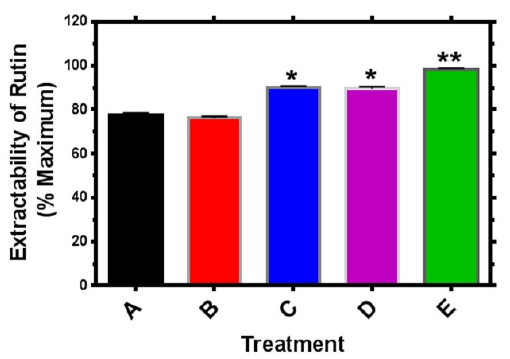
Figure 3. Extractability of rutin from the dried leaves of M. stenopetala . After the dried leaves were subjected to different extraction treatments, the amount of rutin extracted was quantified using HPLC from rutin standard curve. Values were converted into percentage by using the maximum extractible amount as 100%. A = Cold methanol maceration for 20 min; B = Cold water treatment for 20 min; C = Cold water treatment with stirring for 20 min; D = Boiling water (100 °C) added and left for 20 min; E = Boiling in water for 30 min at 250 °C setting. Data are mean and SEM values from four separate